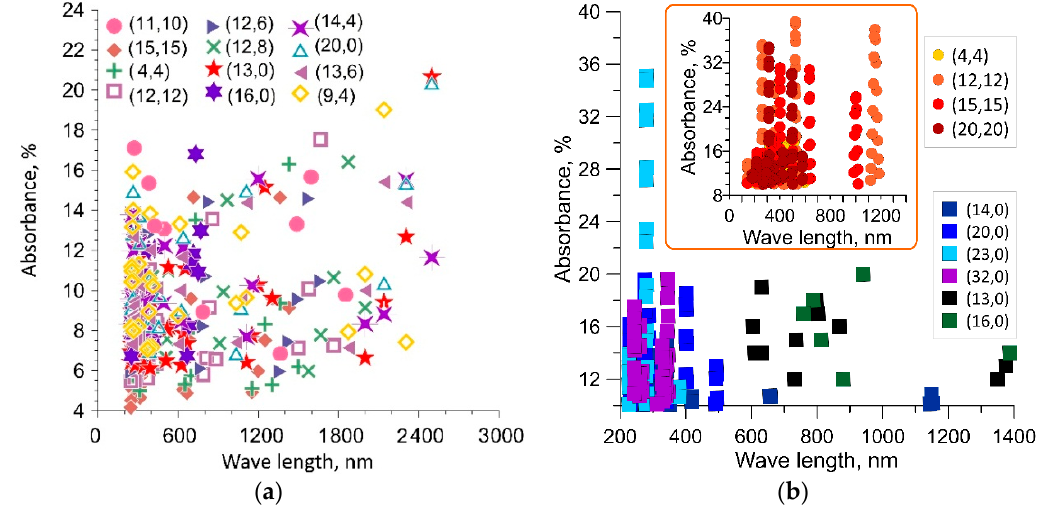
Figure 2. Distribution of absorption maxima for SWCNTs of different diameters: ( a ) SWCNTs of different chiralities; ( b ) achiral SWCNTs (circles correspond to armchair SWCNTs, squares—zigzag SWCNTs).